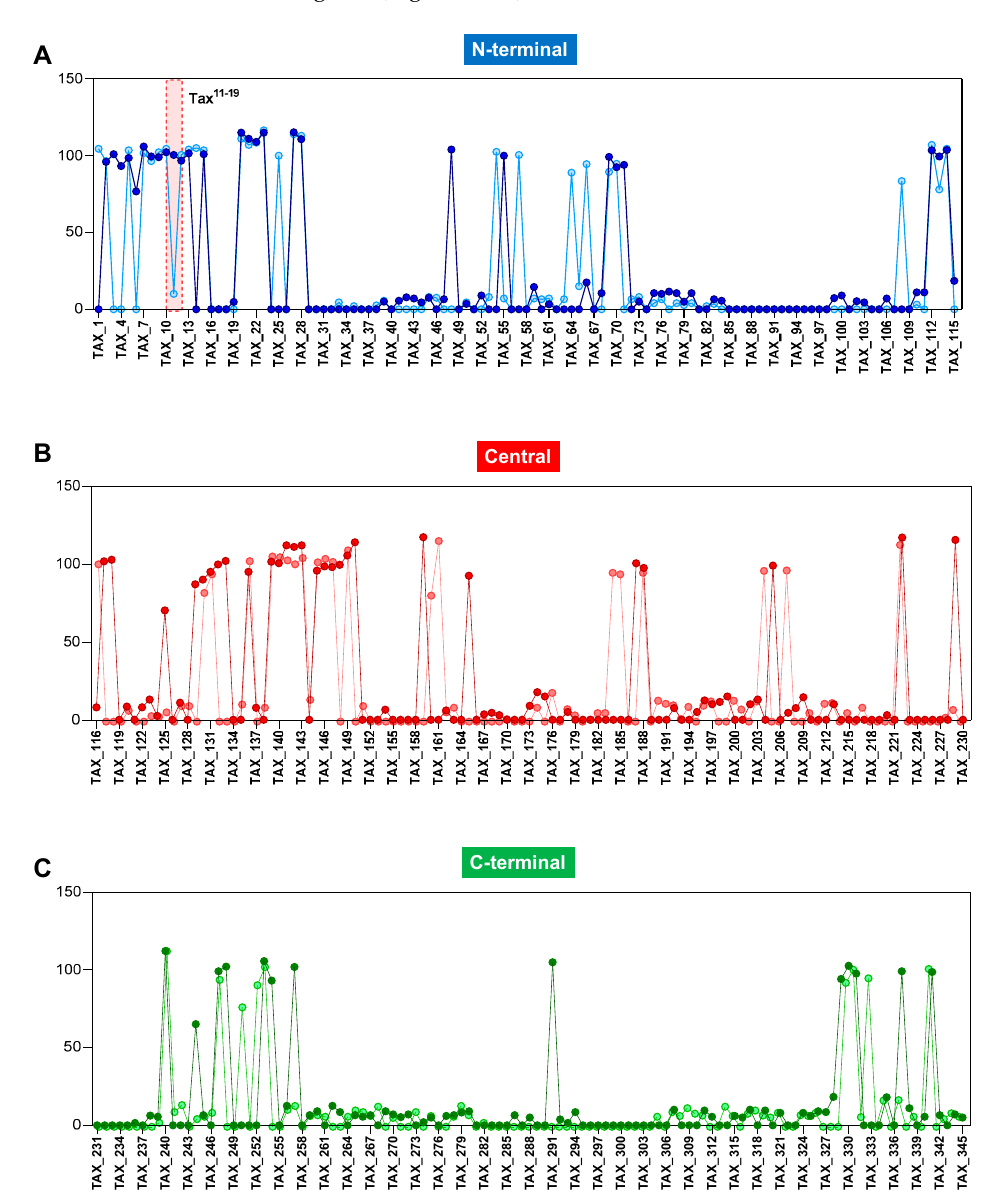
Figure 1. Reactivity of peptides restricted to the HLA-A*02:01 haplotype distributed along the N- terminal ( A ), Central ( B ) and C-terminal ( C ) portions of Tax. Light colors represent reactive peptides with 1 µg/mL of HLA-A*02:01:Ig dimeric protein, and dark colors represent reactive peptides with 10 µg/mL of HLA-A*02:01:Ig dimeric protein. The red rectangle in the dotted line, present in ( A ), represents the HLA-A*02:01 reactivity of the Tax 11-19 peptide present in the N-terminal region of Tax.